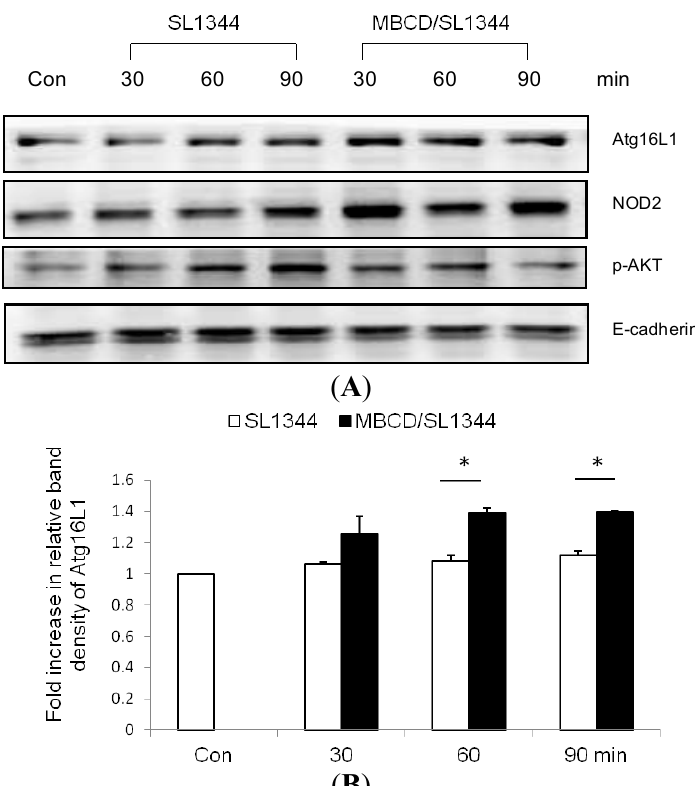
2.3. The Membrane Association of Nucleotide-Binding Oligomerization Domain-Containing Protein 2 (NOD2) and Atg16L1 Is Affected by the Depletion of Membrane Cholesterol The activated autophagy of epithelial cells, depending on nucleotide-binding oligomerization domain-containing protein 2 (NOD2) and Atg16L1 expression, increased the killing of Salmonella [15]. To examine whether or not depletion of membrane cholesterol affected the membrane recruitment of NOD2 and Atg16L1, subsequently leading to the activation of autophagy, Western blot of NOD2 and Atg16L1 proteins expression was analyzed in membrane extract of Salmonella -infected Caco-2 cells in the presence or absence of MBCD. As shown in Figure 3, depletion of membrane cholesterol by MBCD enhanced the NOD2 and Atg16L1 proteins expression in membrane fraction isolated from MBCD-treated Salmonella -infected Caco-2 cells. Figure 3. The effect of cholesterol on the membranous recruitment of nucleotide-binding oligomerization domain-containing protein 2 (NOD2) and Atg16L1 in Salmonella -infected Caco-2 cells. Caco-2 cells were uninfected (Con) or infected by wild-type S . typhimurium strain SL1344 for indicated times, in the presence or absence of MBCD. Immunoblots were performed on membrane lysates with antibody to detect NOD2, Atg16L1 and phosphorylated Akt proteins expression, and E-cadherin for normalization of membrane proteins. Representative immunoblots ( A ) and densitometric quantification of immunoreactive bands ( B , C ) are shown; The relative band intensities of Atg16L1 ( B ) and NOD2 ( C ) in untreated (white) and treated (black) Caco-2 cells were quantified as fold increases compared with the control cells. Each value represents the mean ± SEM of 3 independent experiments. An asterisk indicates a significant difference ( p <